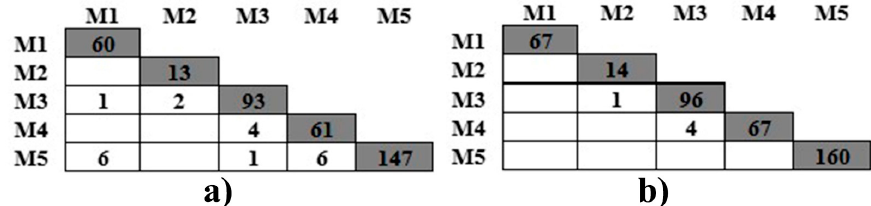
Figure 7. Frequencies of violation records at monitoring sites and the corresponding frequencies of independent pollution episodes: ( a ) frequencies of violation records; ( b ) frequencies of independent pollution episodes. The diagonal values are statistical results for single-site cases and the non-diagonal values are results for two-site cases.